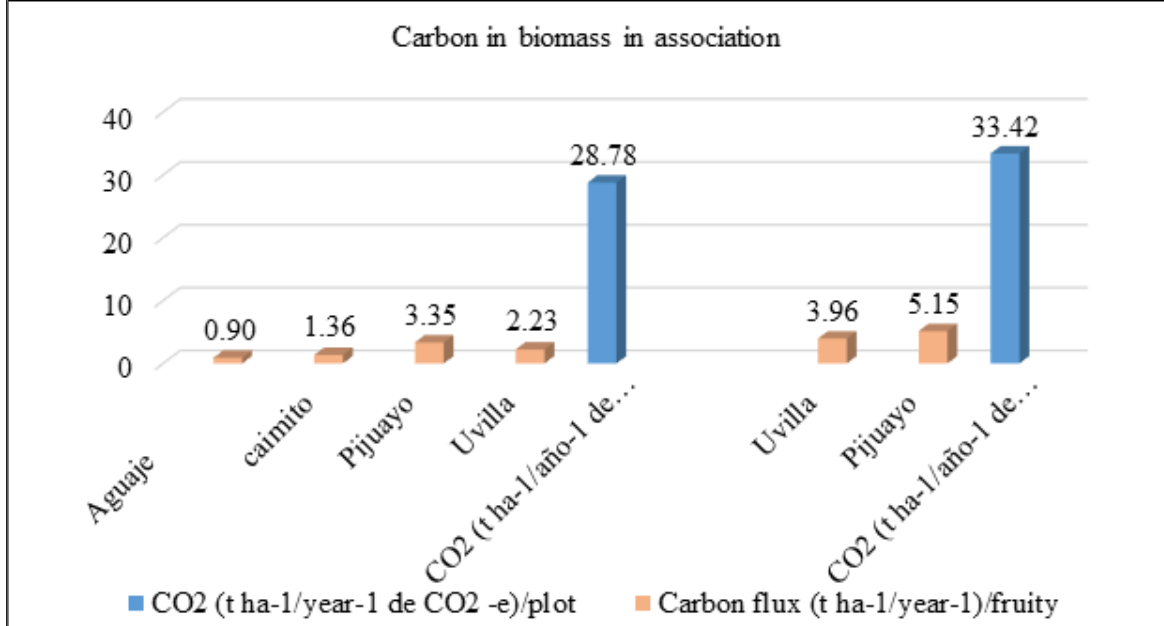
Figure 4: Carbon sequestration in biomass of fruit trees association in the producing plots of Amazonian Fruit trees in Iquitos – Nauta road in